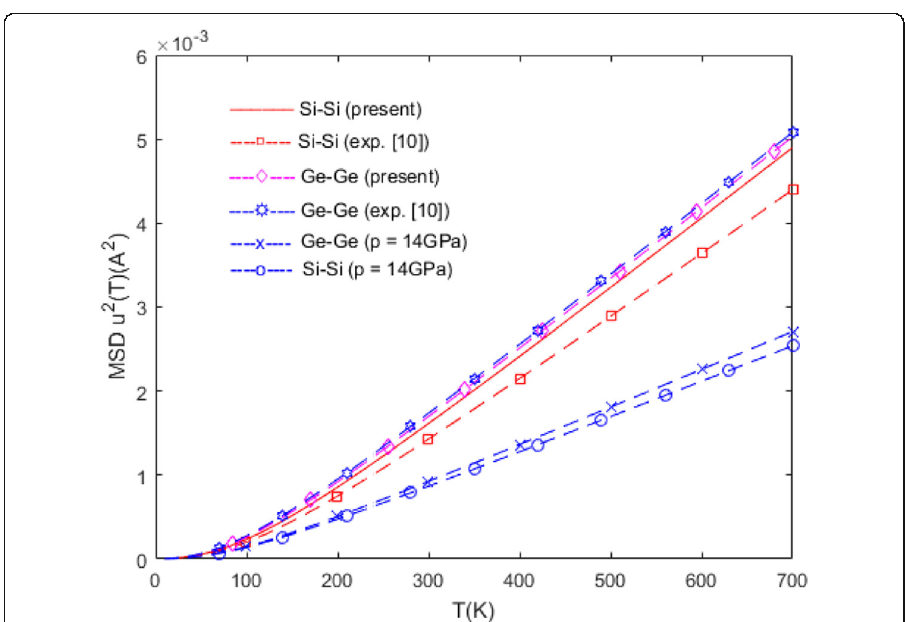
Fig. 6 Dependence on temperature of mean square displacement MSD under pressure effects up